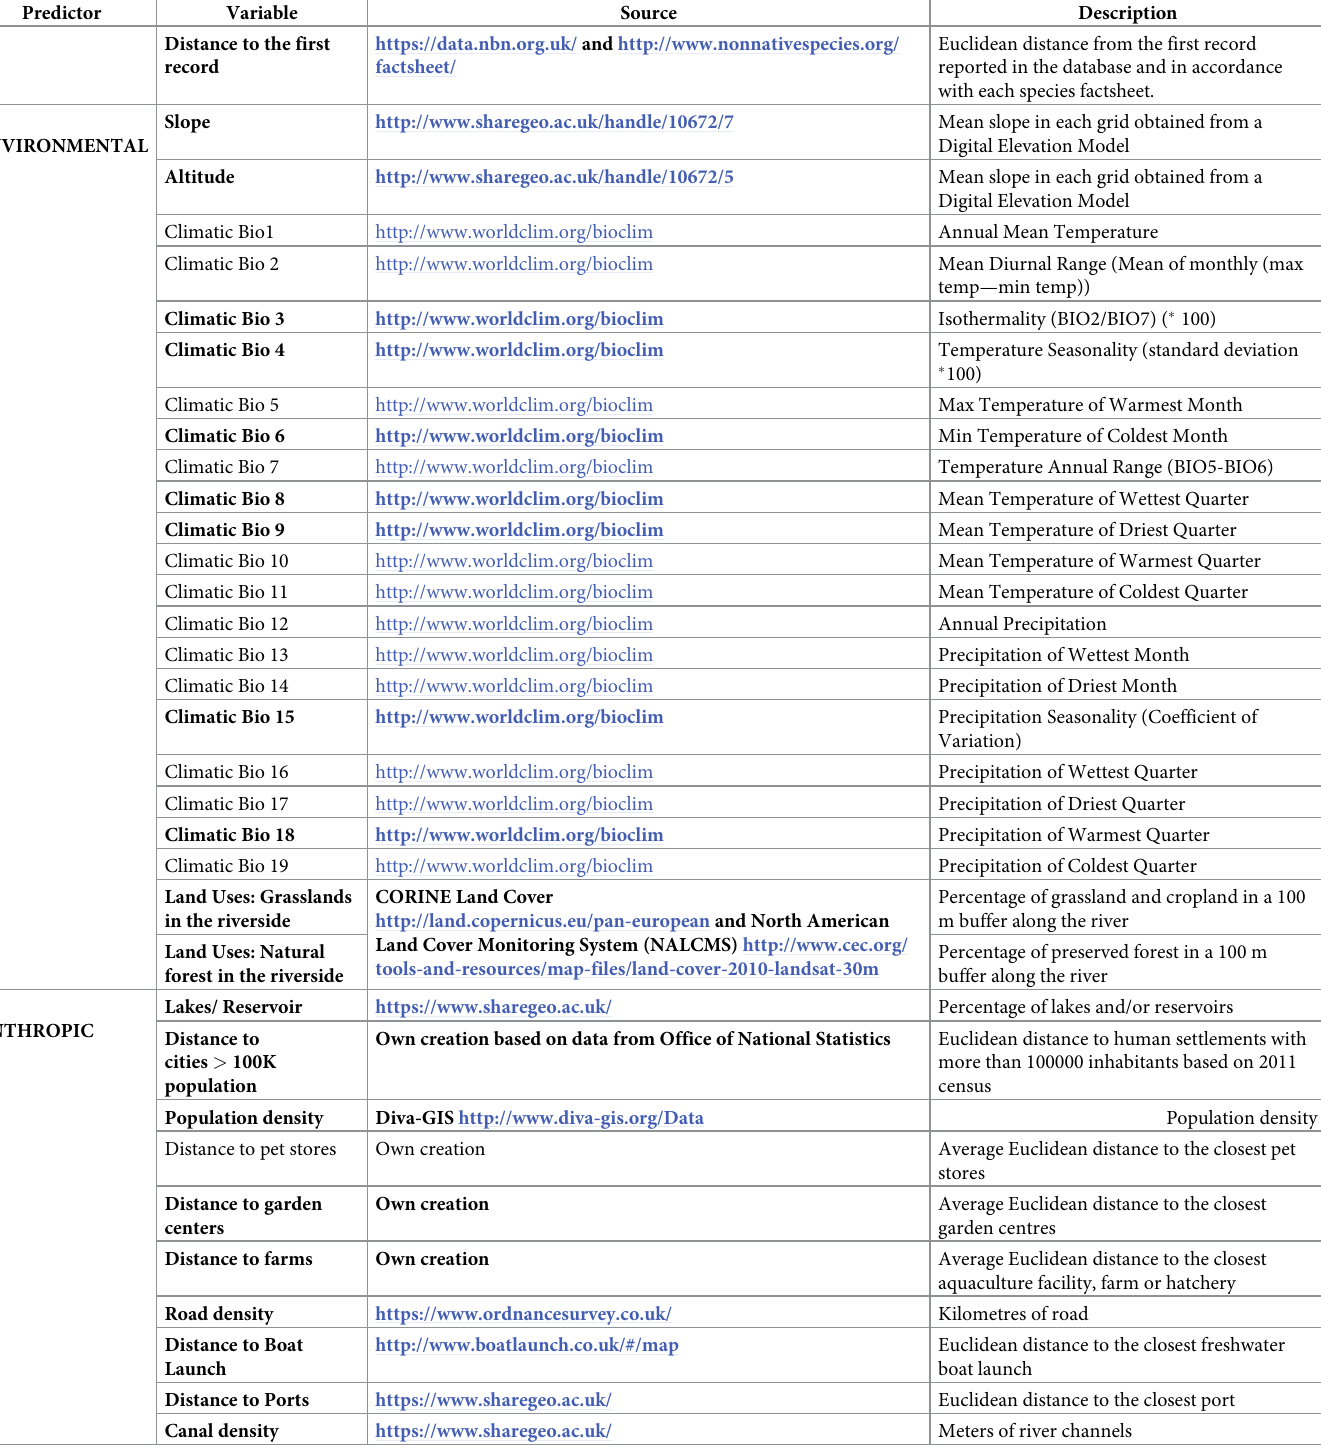
Table 1. Predictor variables used to generate the Species Distribution Models. Variables in bold had VIF scores smaller than 10 [33] and were included in the Species Distribution Models.